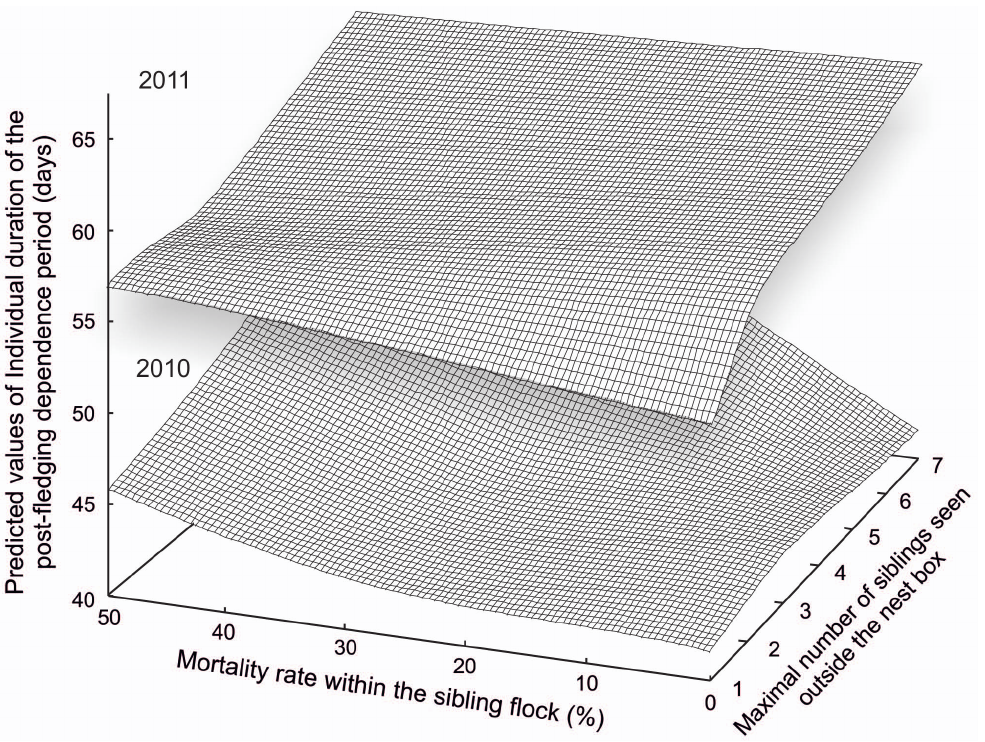
Figure 6. Predicted values of the individual duration of the post-fledging dependence period for both study seasons (2010 and 2011) plotted against the mortality rate (%, the number of dead fledglings as percentage of the total number of fledglings) within the sibling flock and the maximal number of siblings seen outside the nest box.